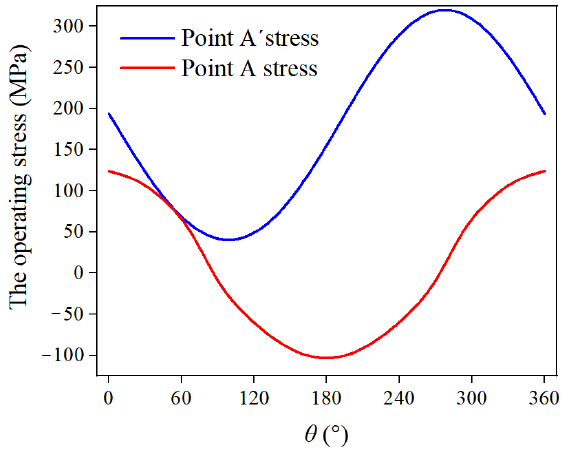
Figure 15. Stress history at hazard points before and after stress superposition.